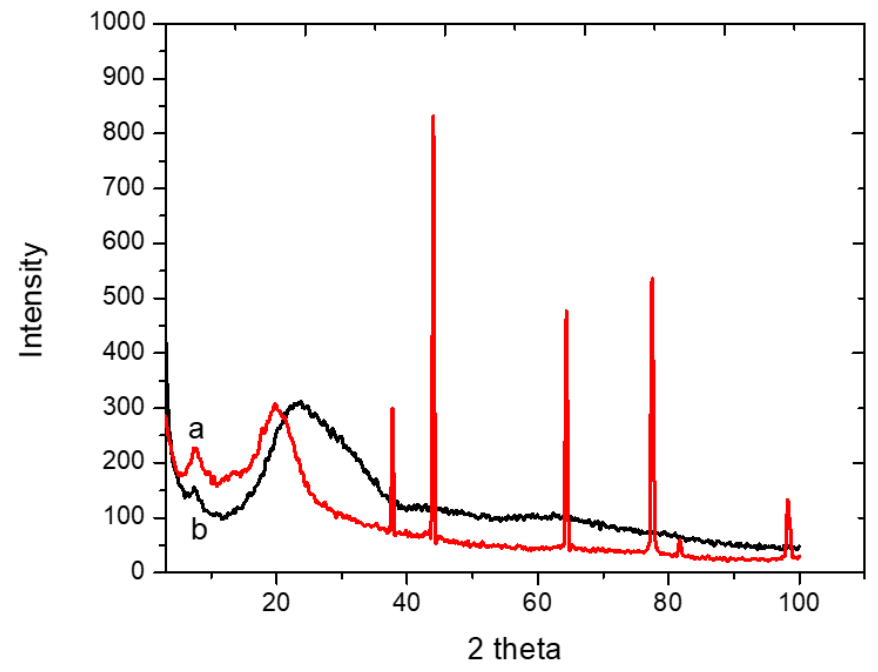
Figure 4. The X-ray diffraction (XRD) patterns of (a) adsorbent 1 and (b) adsorbent 2 .